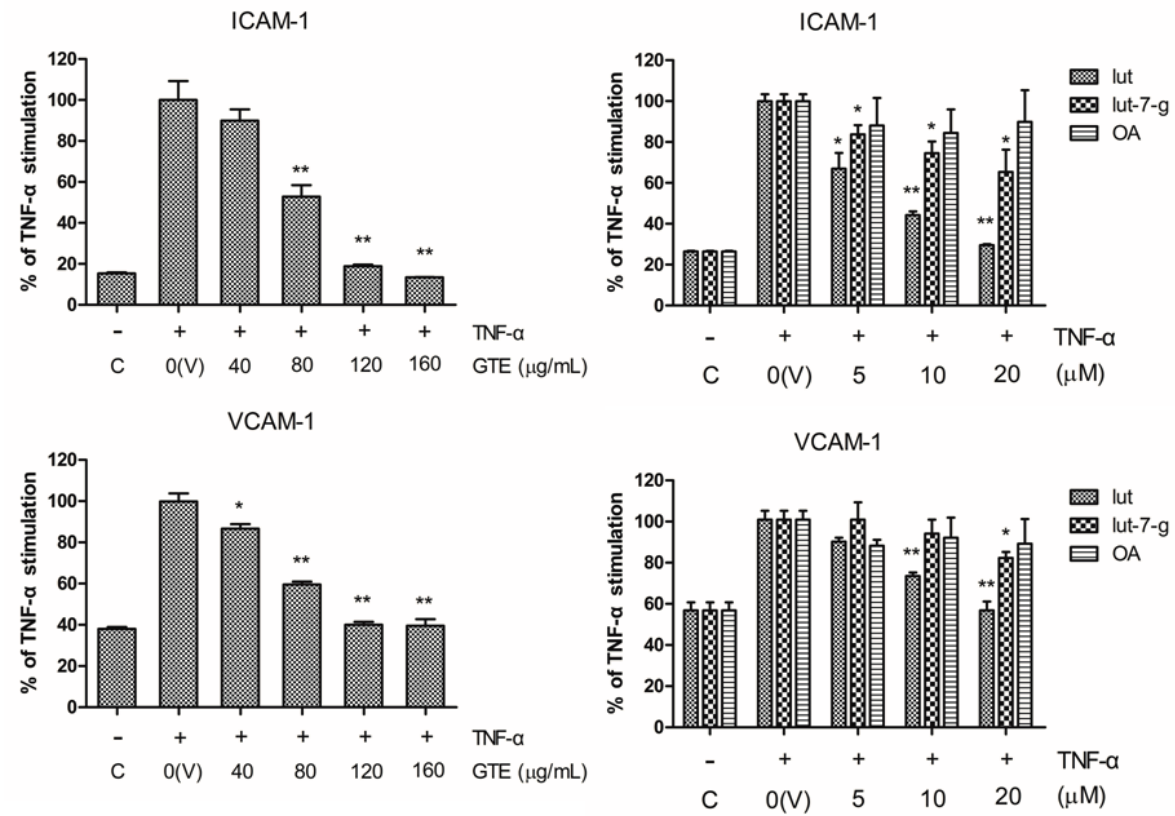
Figure 3. Inhibitory effects of GTE, lut, lut-7-g, and OA on the expression of ICAM-1 and VCAM-1 in TNF- α -activated HUVECs. TNF- α -activated HUVECs were pretreated with vehicle only (V), GTE (40, 80, 120, 160 μ g/mL), lut (5, 10, 20 μ M), lut-7-g (5, 10, 20 μ M), and OA (5, 10, 20 μ M) for 2 h. The expression of ICAM-1 and VCAM-1 on plasma membranes of HUVECs was measured by ELISA. A significant difference from the vehicle was indicated as, * p < 0.05, or ** p < 0.01 (Student’s t